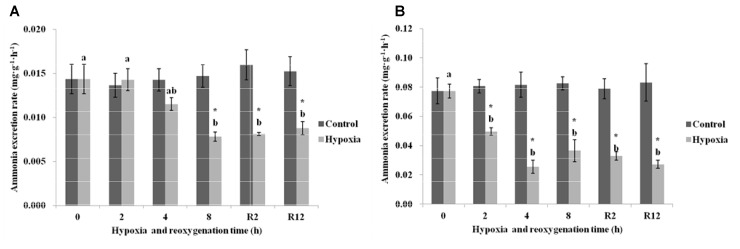
Effect of environmental hypoxia on AER of E. sinensis
(A) and P. sinensis
(B). There was no significant difference between bars with the same letter (P < 0.05). Asterisk represents a significant difference between control and hypoxia groups at the same time point (P < 0.05).